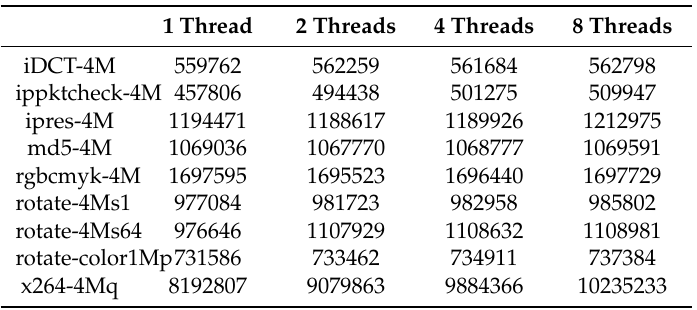
Table A1. Absolute Numbers of L2